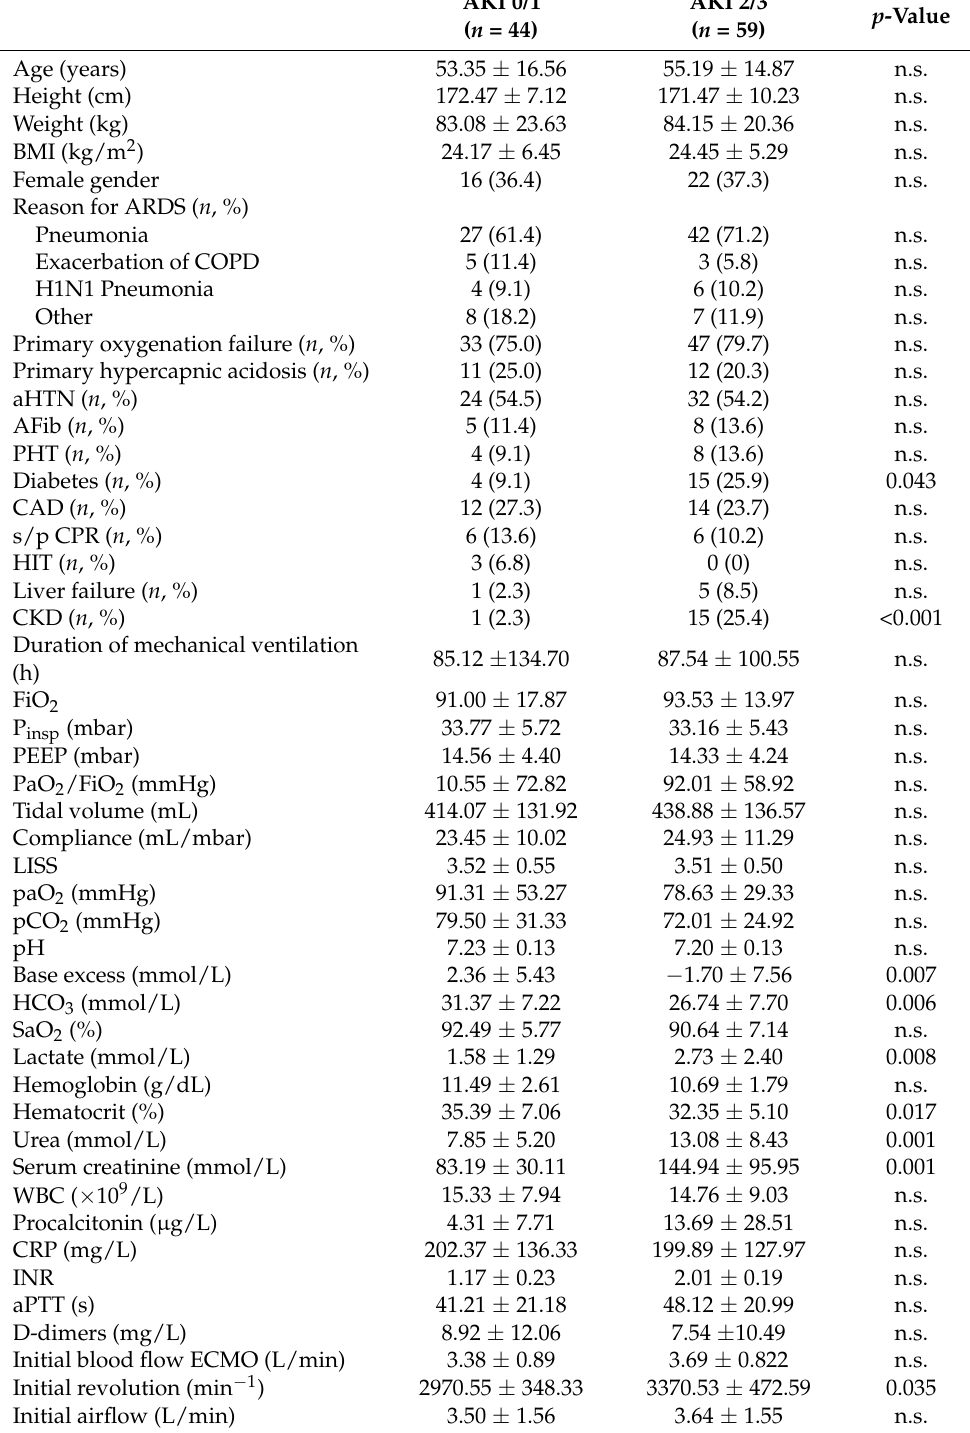
Table 1. Patients’ clinical and laboratory pre-ECMO characteristics, between AKI and non-AKI